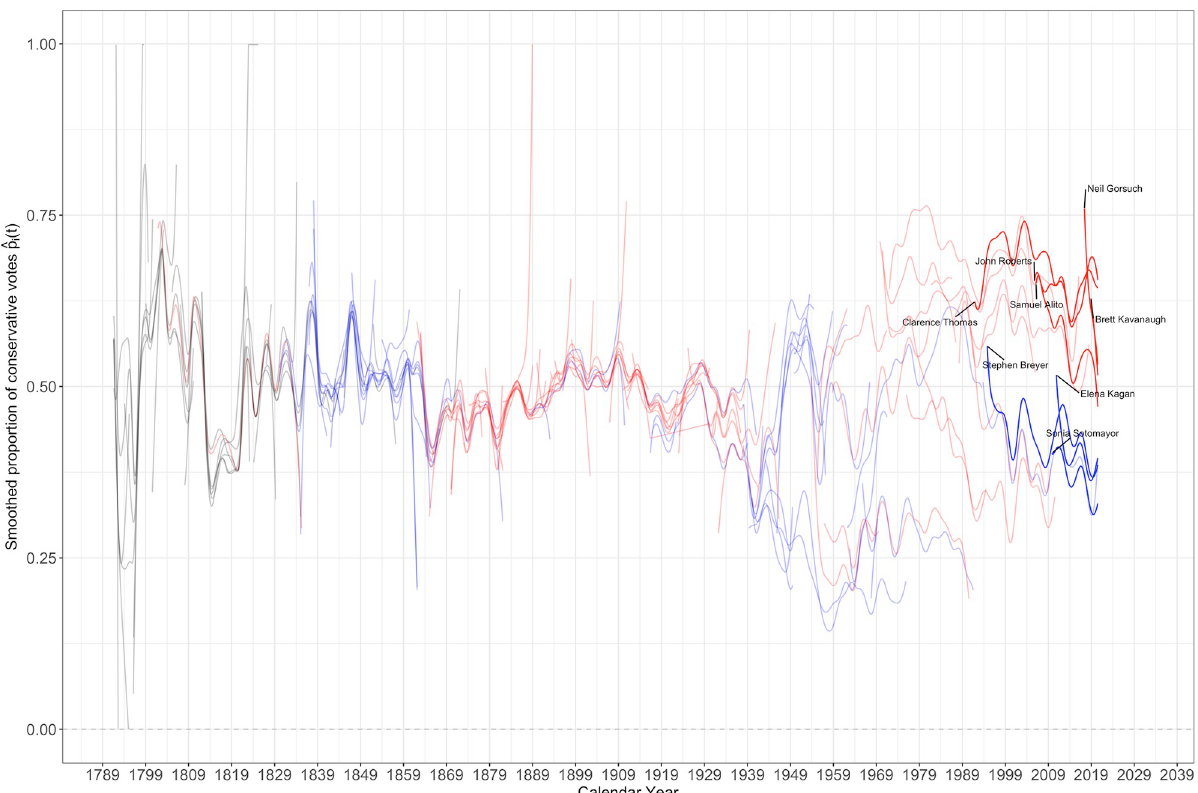
Fig 1. Pre-smoothed curves ^ p ð t Þ ; i ¼ 1 ; ... ; 113 against calendar year. The curves ^ p ð t Þ represent the smoothed proportion of conservative votes as a i i function of calendar year t for the i -th justice and thus the ideology of the 113 justices in the sample. The curves are color coded by the nominating president’s party affiliation: red stands for a justice nominated by a Republican, blue for a justice nominated by a Democratic president and gray for a justice nominated by a third party president. The currently active justices are highlighted.